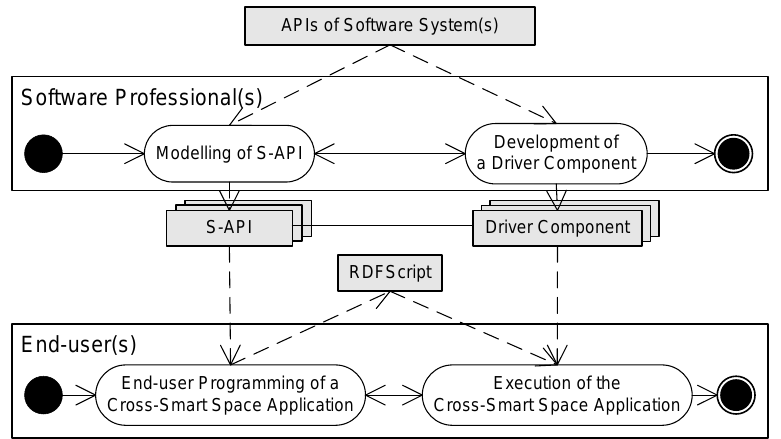
Figure 3. A two-level workflow for the creation of cross-smart space